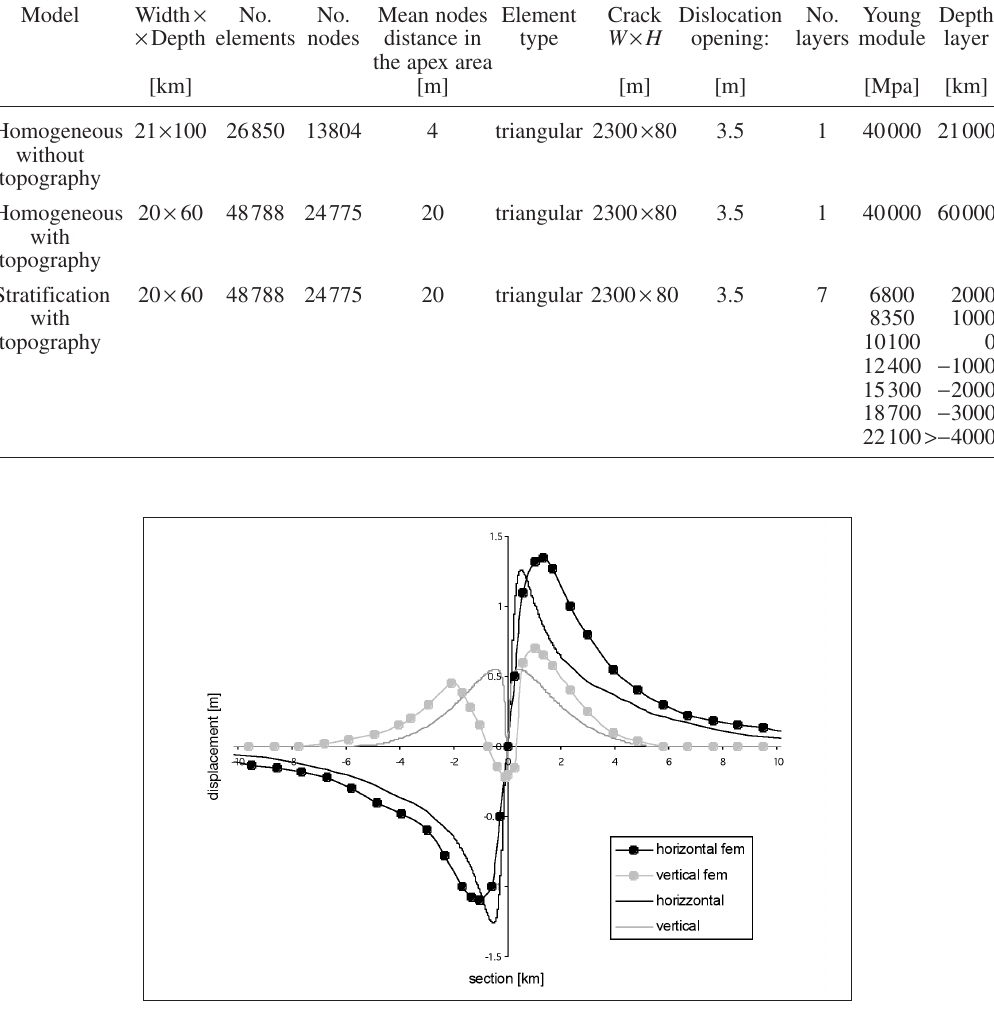
Fig. 4. Comparison between the deformation fields of a model in a homogeneous half-space medium without topography and a model homogeneous half-space with real topography. The top of the crack is located at 1420 m a.s.l.; the zero of the abscissa corresponds to the crack projection onto the surface.